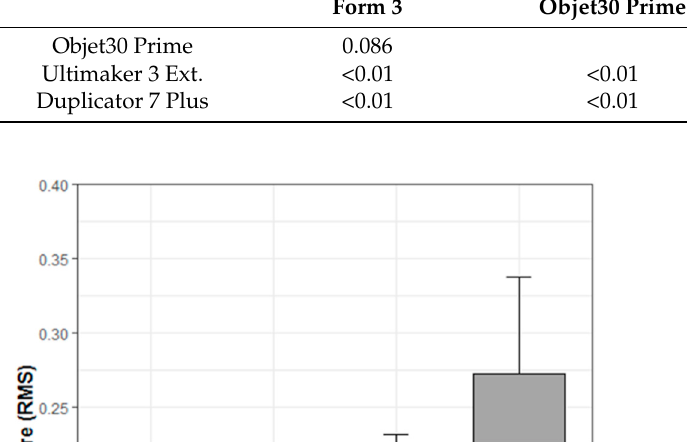
Table 5. p -Values of the Tukey–Kramer post hoc test for the accuracy of 3D printers.